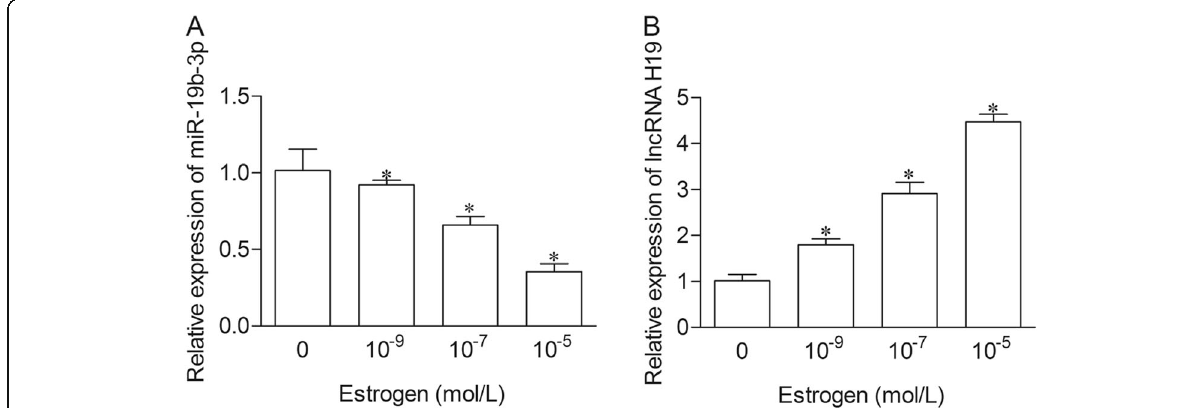
Fig. 5 Estrogen down-regulated miR-19b-3p and up-regulated H19 in BMSCs. BMSCs were treated with different concentration of E2 (10 − 9 , 10 − 7 and 10 − 5 mol/L). The expression of miR-19b-3p ( a ) and H19 ( b ) were measured by qRT-PCR. * P < 0.05 versus control